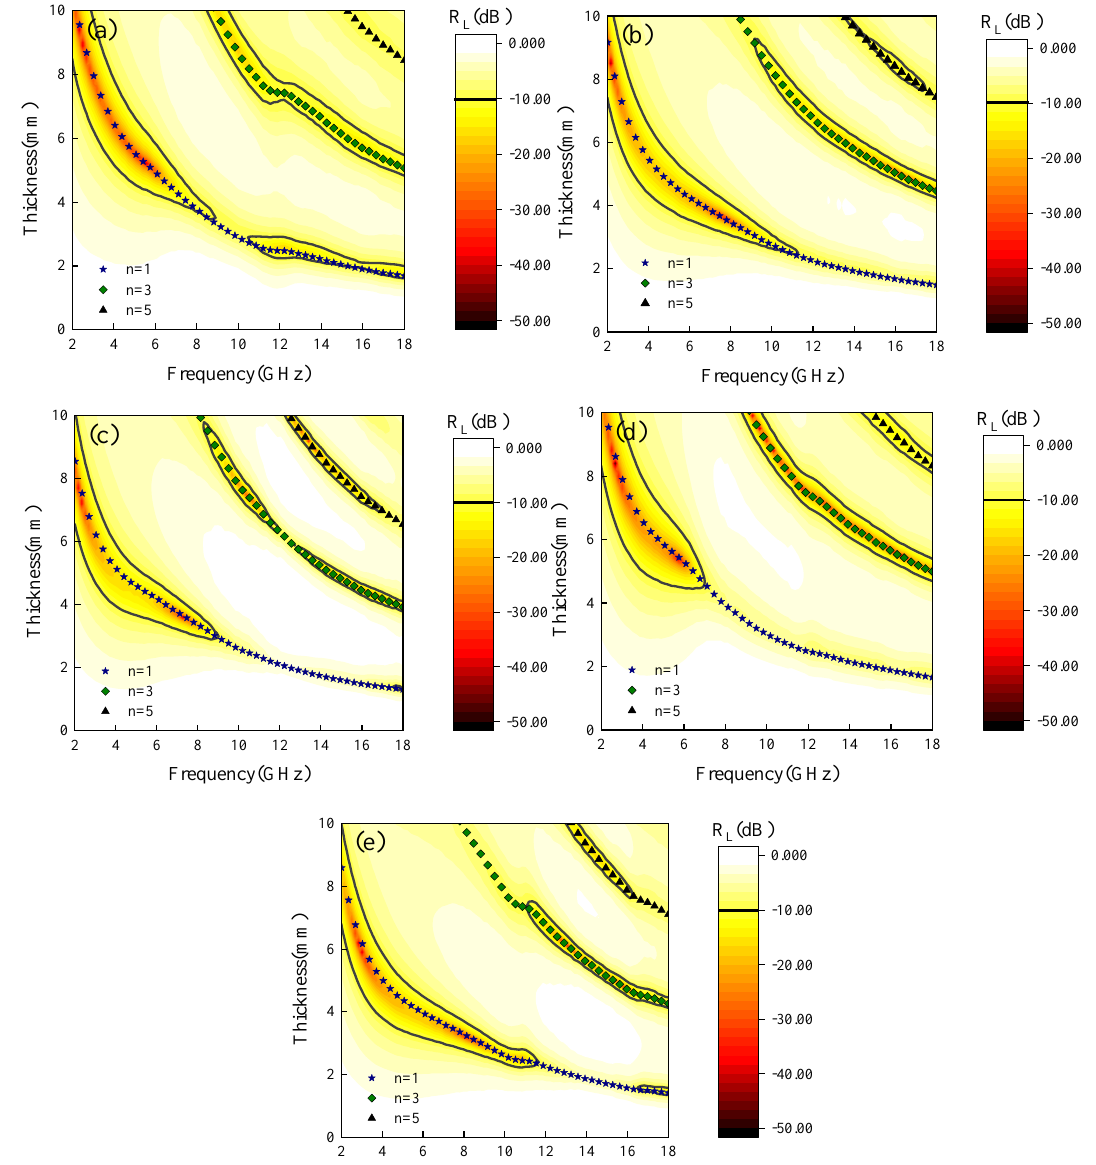
Figure 7. Fe 3 O 4 reflection loss diagrams: ( a ) S1, ( b ) S2, ( c ) S3, ( d ) S4 and ( e ) S5.